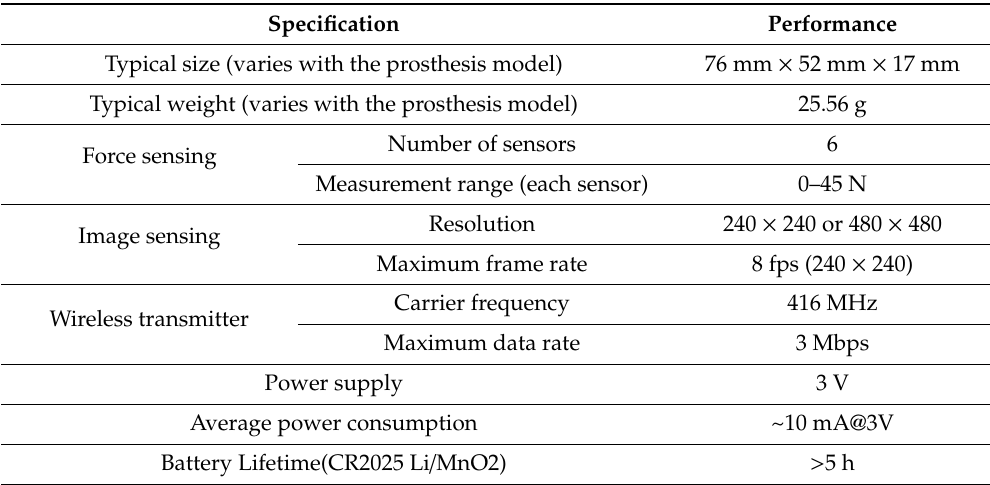
Table 1. Sensing device performance